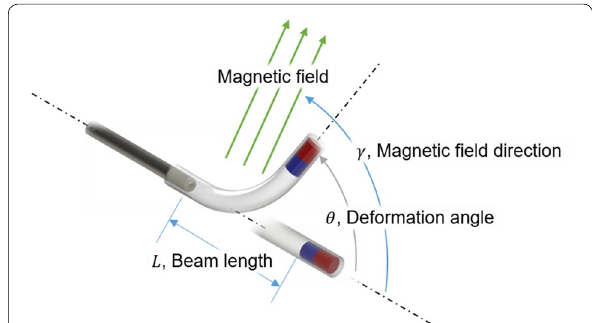
Fig. 2 Steering and actuation of a flexible microrobot controlled by an external magnetic field